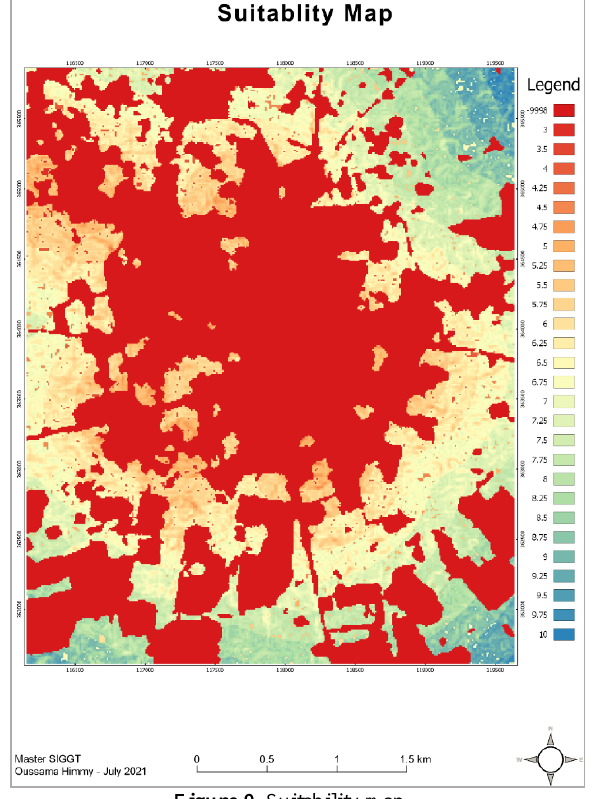
Figure 9 . Suitability